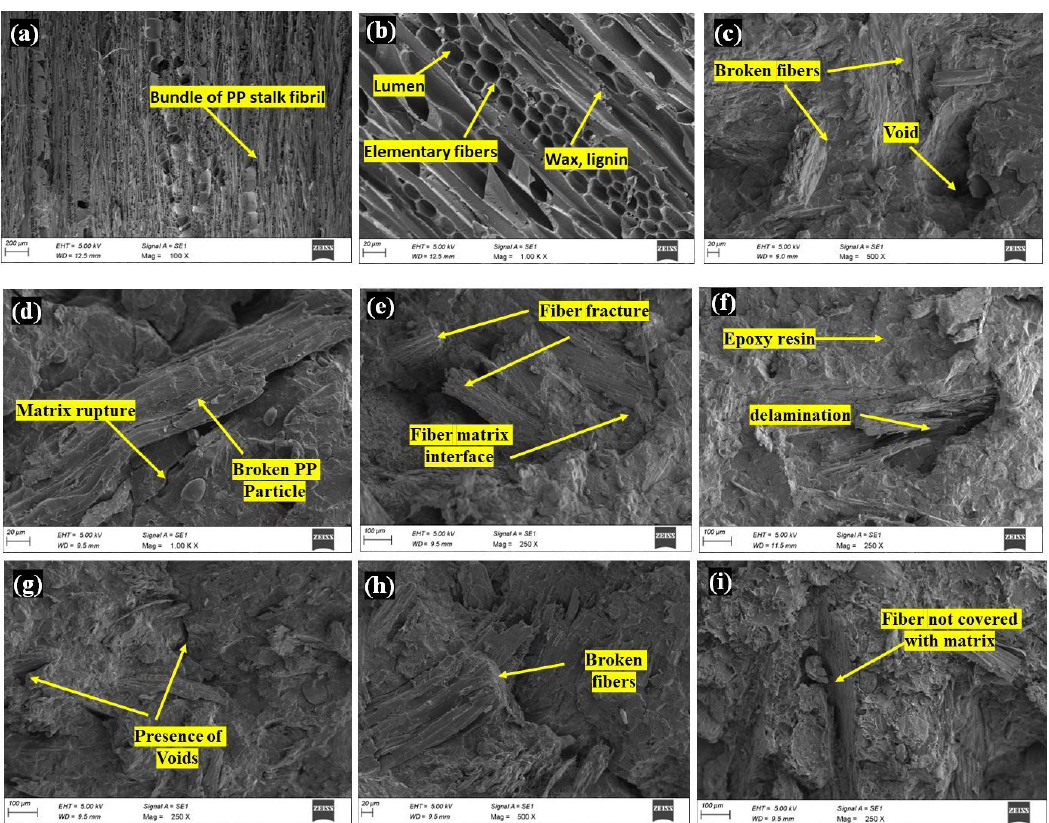
Figure 7. SEM images of PP stalk and EP2 composites: (a) and (b) PP stalk particles; (c), (d), (e), and (f) Tensile fractured specimens; (g), (h), and (i) Flexural fractured